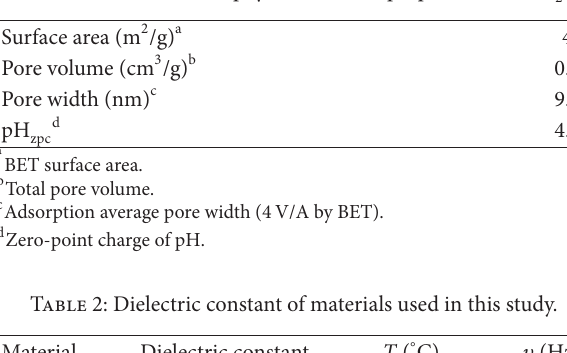
T 1: e measured physicochemical properties of MnO